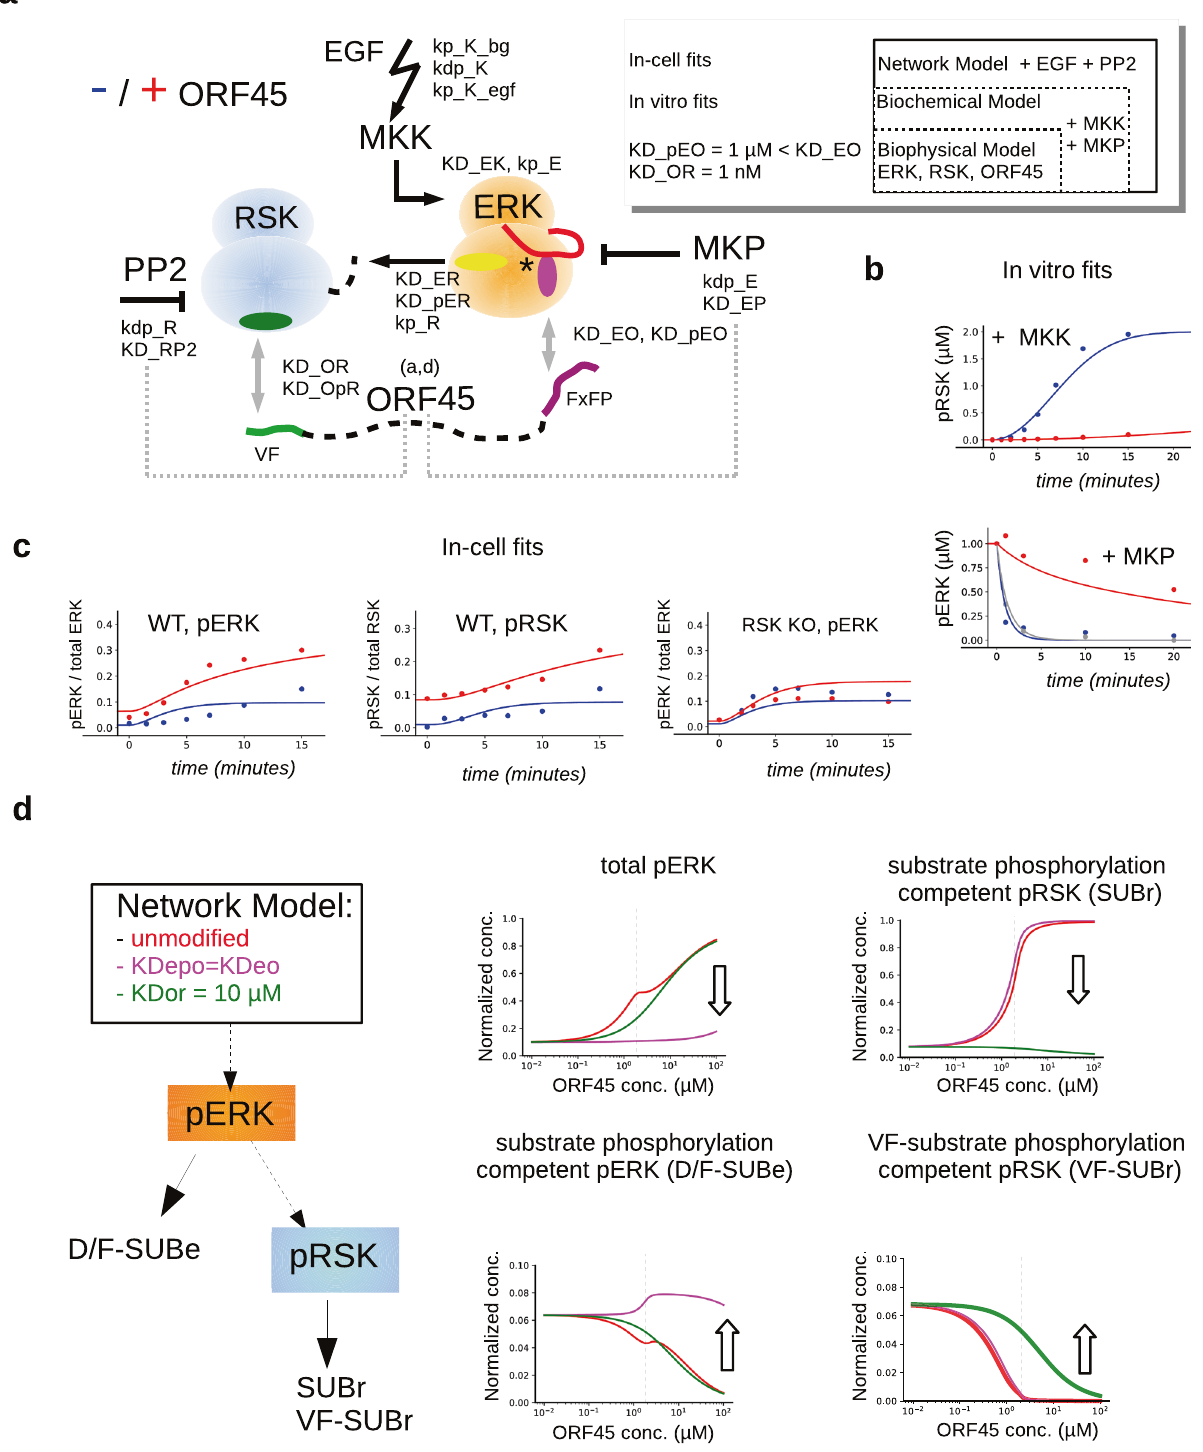
(Supplementary Methods and Supplementary Table 3). In addition, a new phosphatase acting on RSK was introduced and the in-cell protein concentrations were set to realistic values (Network Model). The maximum level of ppERK upon EGF treatment was determined experimentally (~15% of the total ERK level at 15 min; Supplementary Fig. 6). The Network Model — which focuses on the submodule limited to kinase/phosphatase/ substrate binding and catalytic reactions — produces kinetic